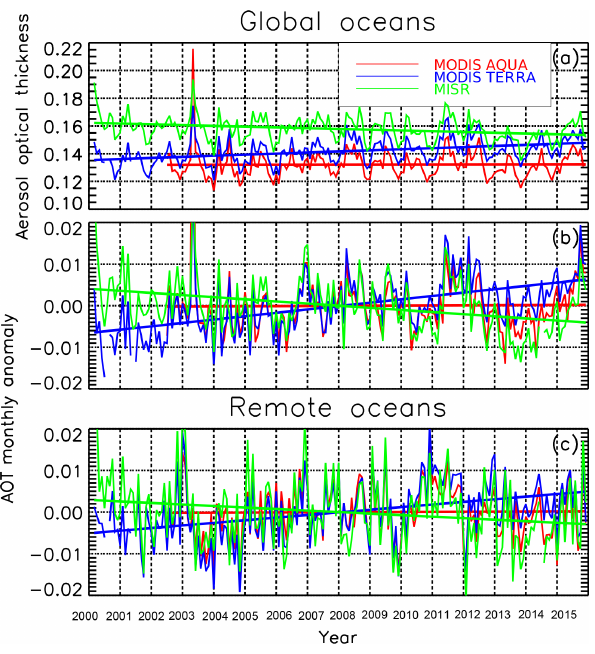
Figure 3. (a) Monthly averaged global AOTs derived using MODIS C6 DT aerosol products for Aqua (red), Terra (blue) and MISR (green). Straight lines are the linear fits for the monthly data. (b) Similar to (a) , but for the deseasonalized, monthly averaged AOTs. (c) Similar to (b) , but for the remote-ocean region as described